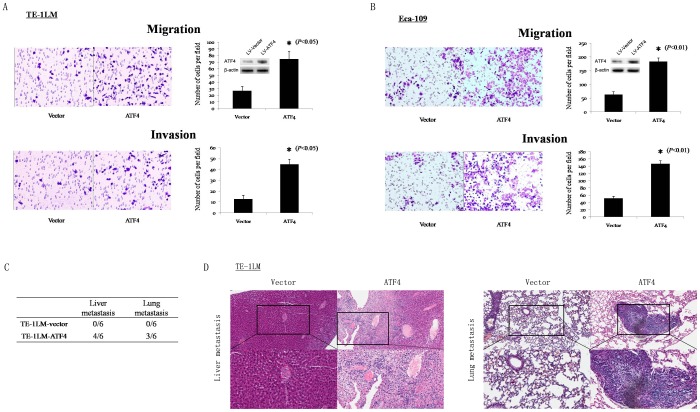
Overexpression of ATF4 promotes tumor cell invasion and metastasis.
In vitro migration and invasion assays in TE-1LM (A) and Eca-109 (B) cells that were stably transfected with LV-vector or LV-ATF4. Inset, relative ATF4 protein expression levels as determined by Western blot. (C) Incidence of metastasis in mice implanted with TE-1LM-vector or TE-1LM-ATF4 cells. (D) Representative hematoxylin and eosin staining of the lungs and livers of mice.